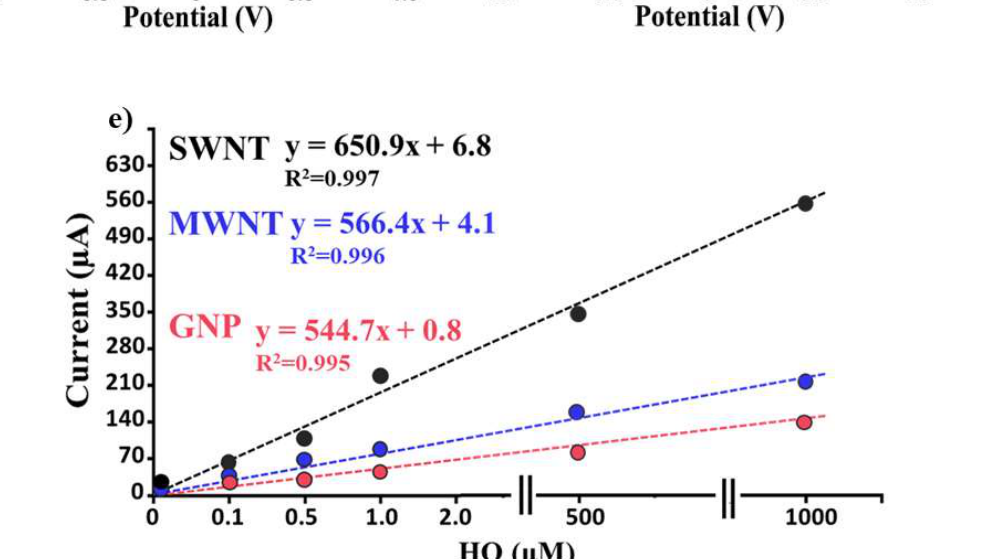
Figure 5. Dose–response voltammograms. Comparison of the CVs obtained by analyzing with all our platforms (SWNTs, MWNTs, GNPs, and bare SPEs) ( a ) the same concentration of HQ (5 mM) and ( b – d ) several HQ concentrations (from 0.1 µ M to 1 mM); ( e ) relative linear regressions. Curves of one representative CNM-modified SPE sensor of at least 6 analyzed platforms are presented.